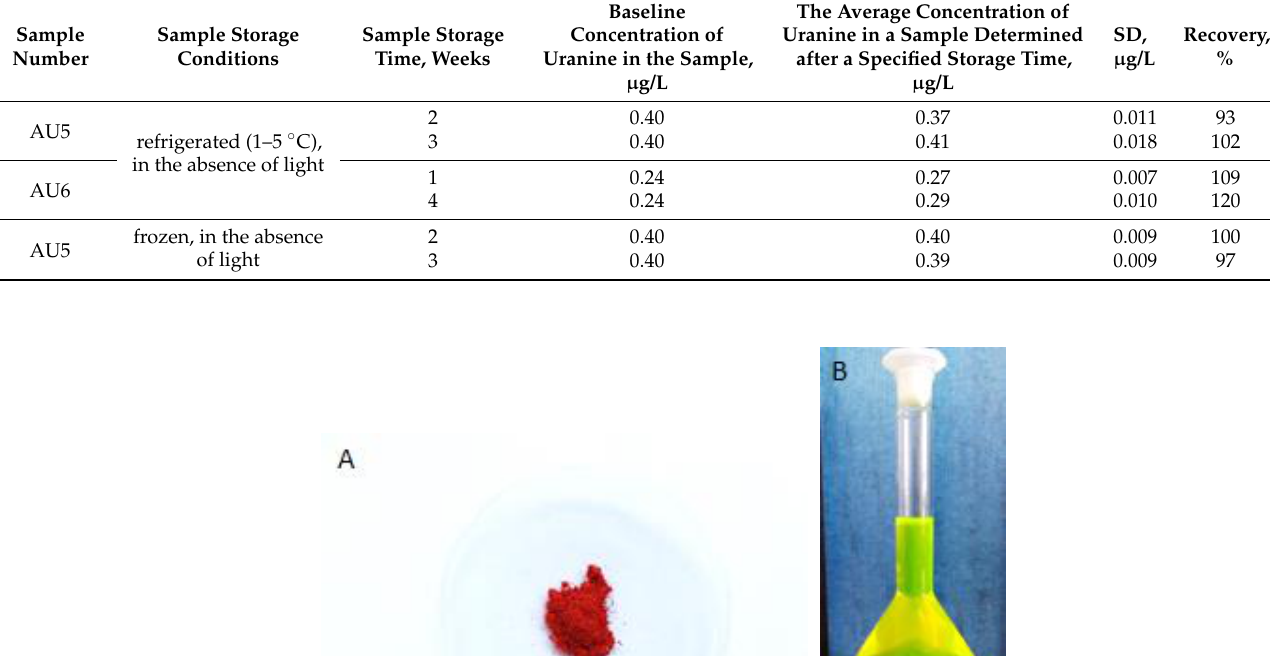
Figure 3. Solid uranine ( A ) and a 100 mg/L aqueous solution of uranine ( B ) (photo M. Gajec). Uranine decomposes when exposed to light [13 – 16]. Visible light also affects the color of uranine solutions. The color intensity of low-concentration uranine solutions decreases with time [13], whereas in the case of solutions of higher concentration, the color of solutions changes from green-yellow to orange. The change in color of the uranine solution under the influence of light is presented on Figure 4.